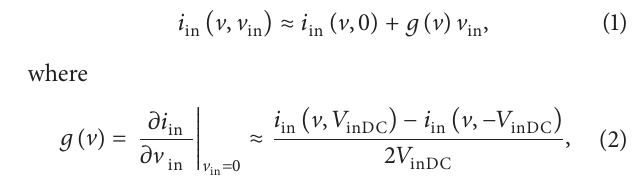
𝑖 ( V , V ) , where V denotes the differential voltage between the in in drain nodes of the ILFD. The LC tank and the transconductor represent the basic oscillator that is perturbed by the injection ( V , V ) , which depends on both the injection signal current 𝑖 in in V , and the tank voltage V in